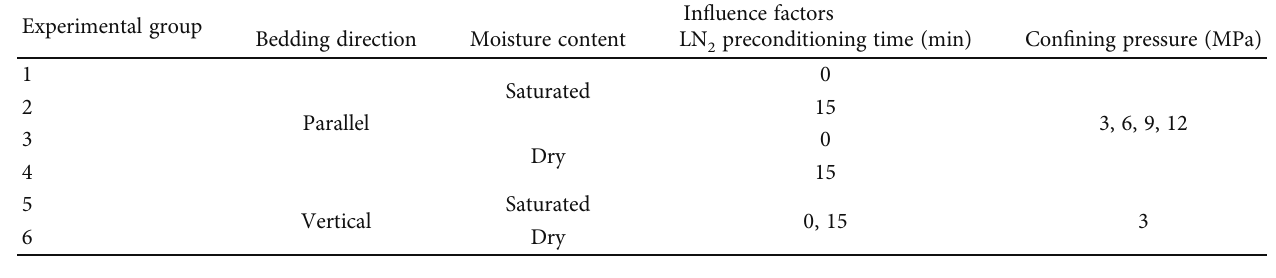
Table 1: Experimental scheme.